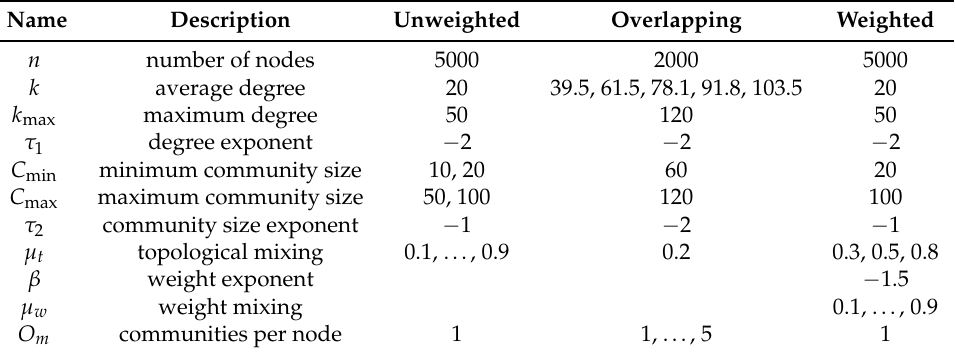
Table 1. Parameters of the LFR benchmark that we use in our